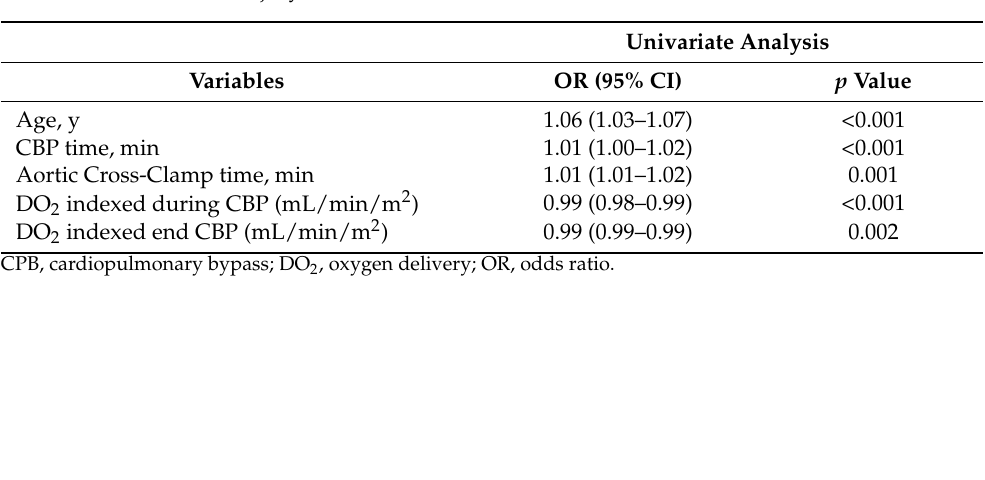
Table 2. Univariate logistic regression analysis for predisposing factors related to Cardiac Surgery- Associated Acute Renal